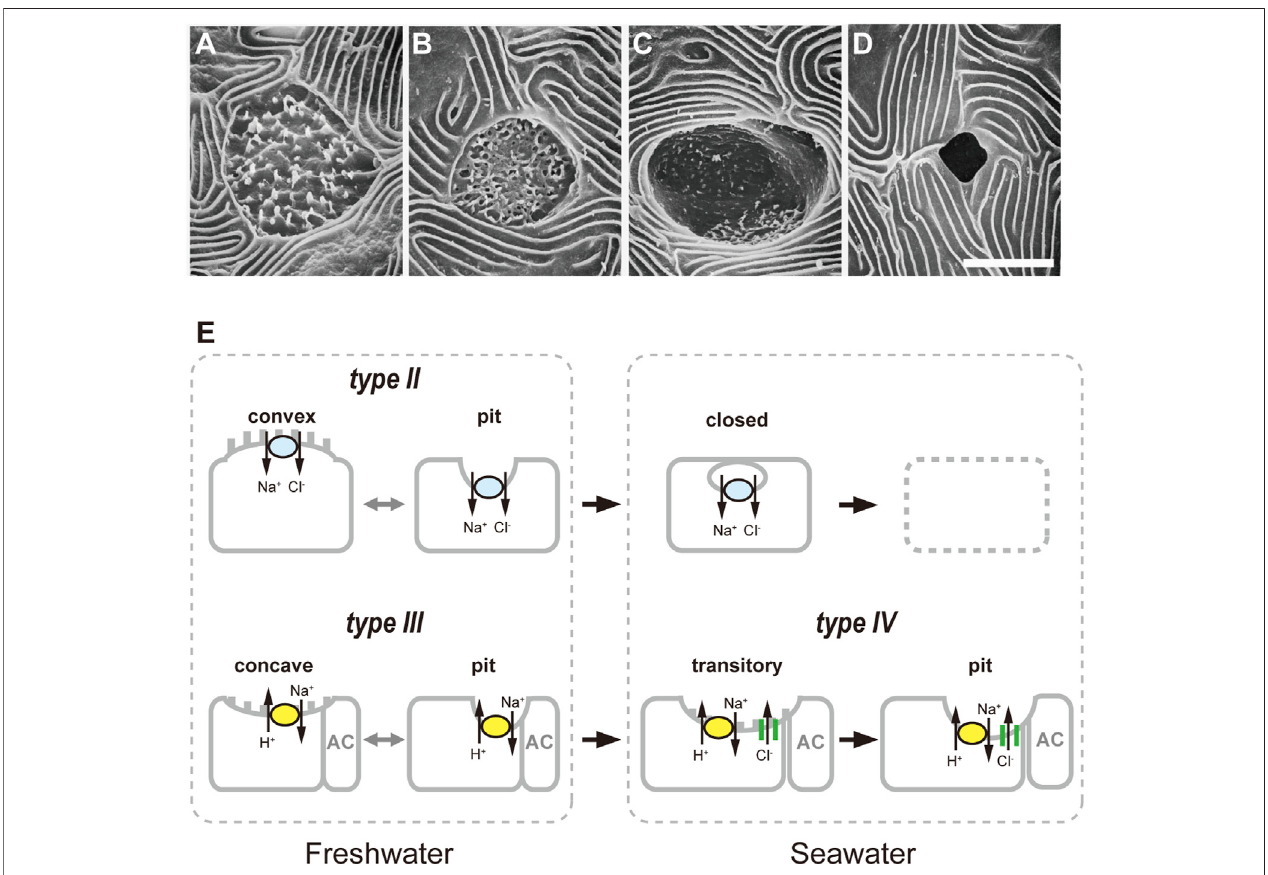
FIGURE 2 | Classi fi cation of apical openings of ionocytes in the gills of Mozambique tilapia. Four types of apical openings, identi fi ed by scanning electron microscopy: a convex apical surface (A) , a concave apical surface (B) , a transitory apical surface (C) and an apical pit (D) . Scale bar, 5 μ m. (E) , Schematic diagrams of relationship between apical opening structure and ionocyte types. The type-II ionocytes with convex apical surfaces or apical pits suspend ion-absorptive function by closing the apical openings as a quick response after transfer from freshwater to 70% seawater, followed by cell disappearance. After transfer, concave apical surfaces or small apical pits typically seen in type-III ionocytes are transformed into enlarged apical pits in type-IV ionocytes via the transitory apical surfaces. Modi fi ed from Choi et al. (2011).